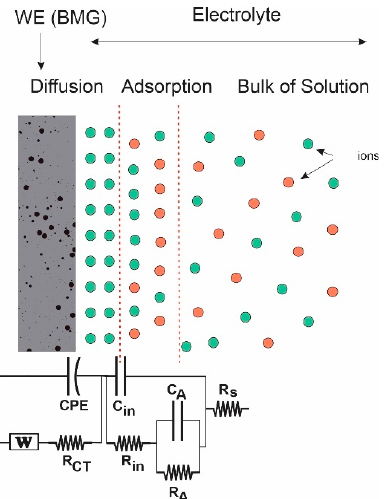
Figure 9. Equivalent circuit with the Warburg and constant phase (CPE) elements used in this work (red circles denote negative ions while green cycles denote positive ions).